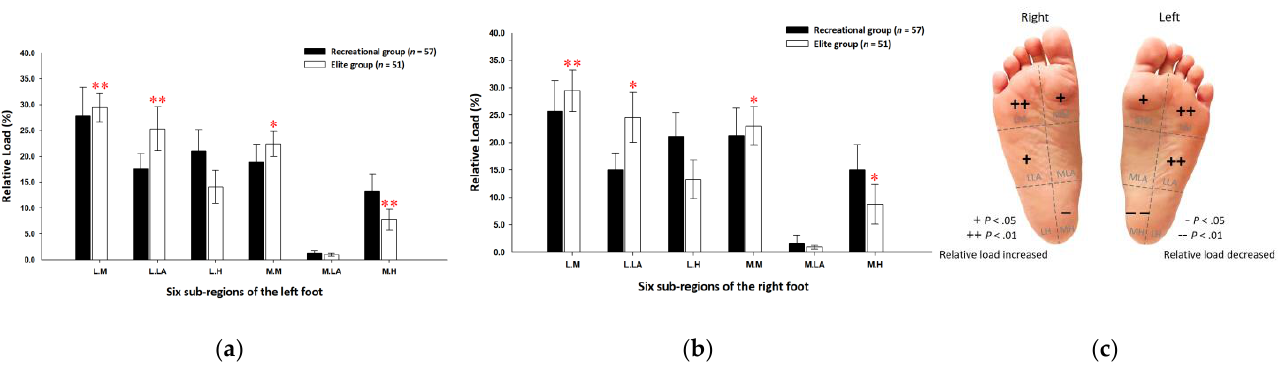
Figure 2. The plantar pressure distributions of the left ( a ) and right ( b ) feet in the six subregions in static standing. De- scription of changes in pressure distribution is illustrated in ( c ) plantar diagram. Through the independent sample t -test, * p < 0.05 and ** p < 0.01 were significantly different between both groups. The six subregions and their abbreviations are as follows: LH, lateral heel; LLA, lateral longitudinal arch; LM lateral metatarsal bone; MH, medial heel; MLA, medial lon- gitudinal arch; and MM, medial metatarsal bone.